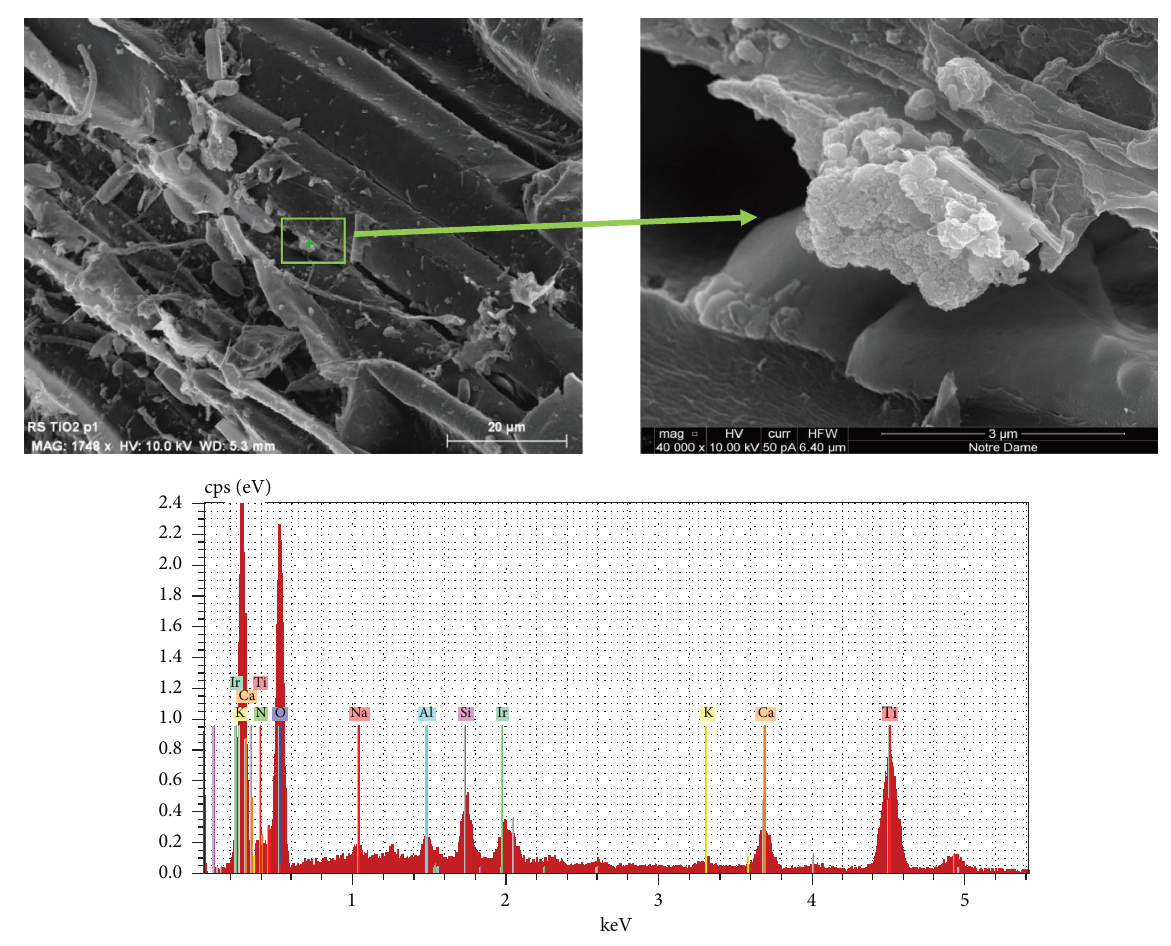
Figure 3: SEM/EDX image of cattail root showing the presence of TiO